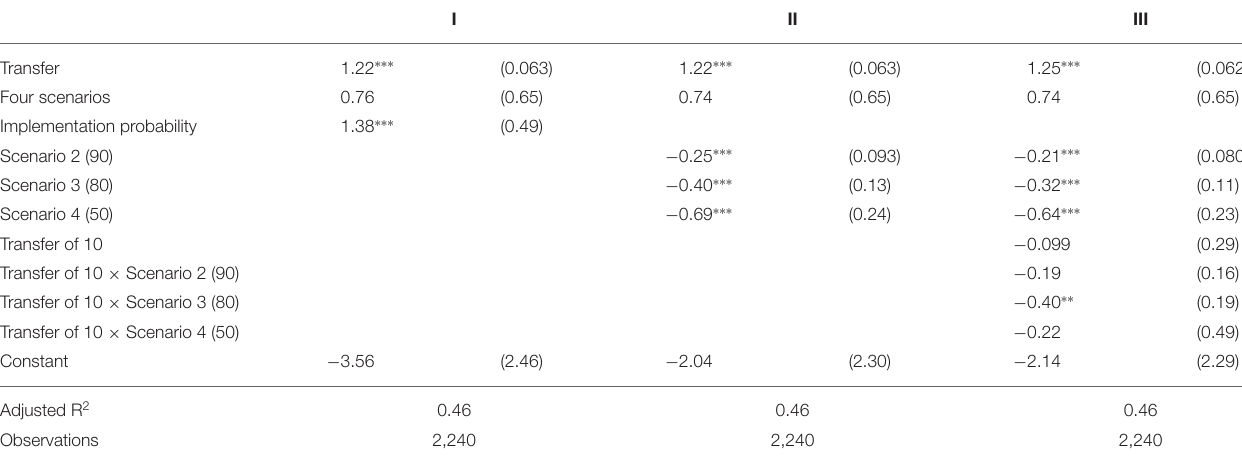
TABLE 1 | Determinants of amount returned.